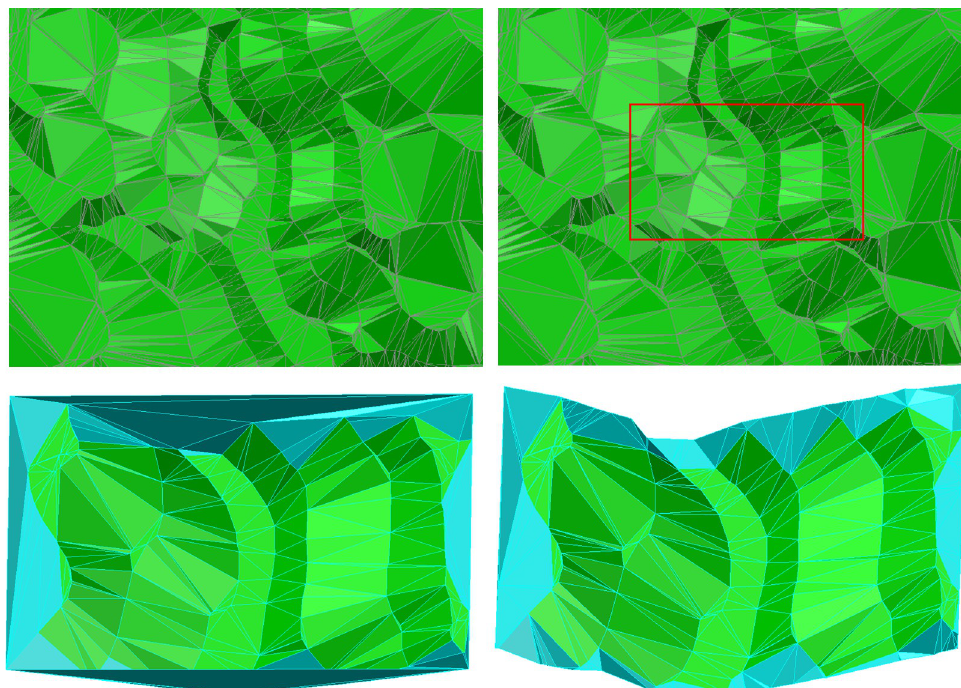
Fig 7. TIN clipping with a convex CP.